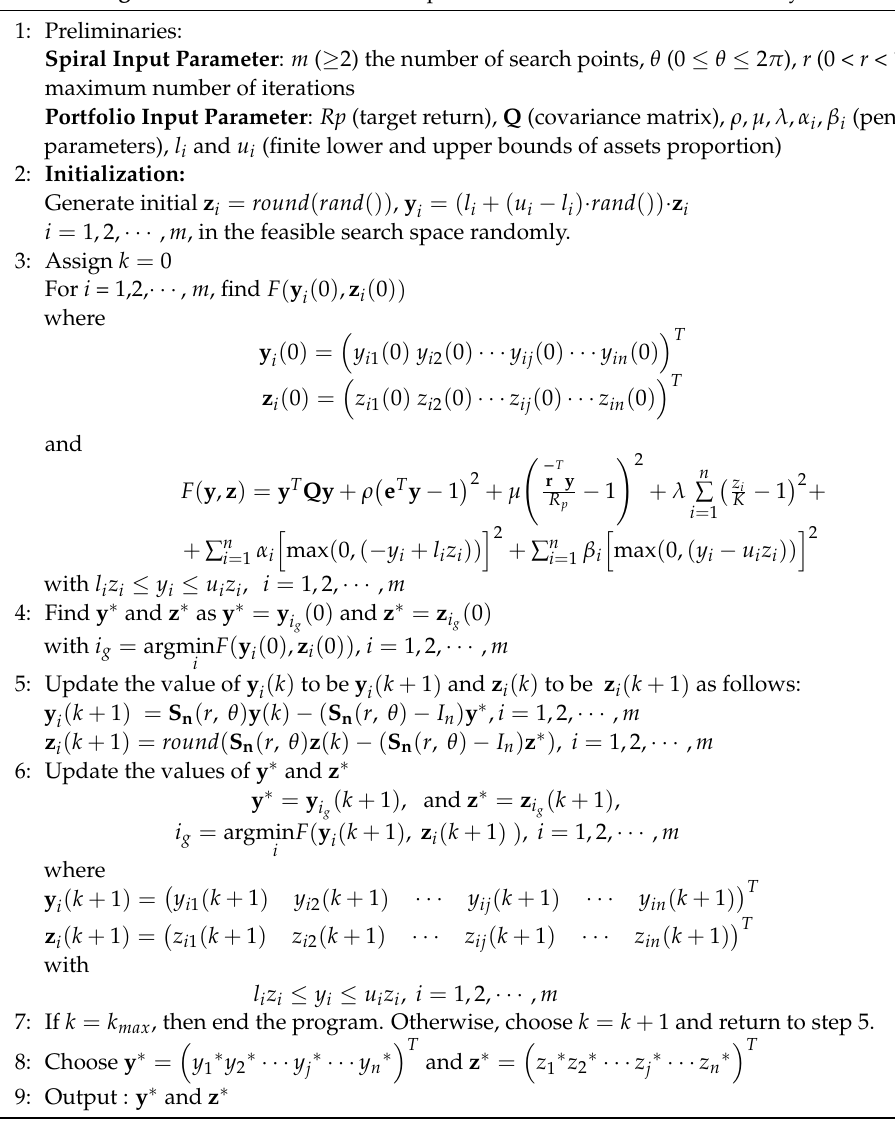
Algorithm 4. SOA for Portfolio Optimization Problem with Cardinality